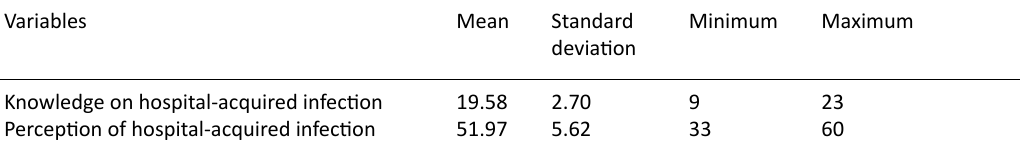
Table 6. Spearman’s rho correlation coefficients between knowledge and perception (n = 262)